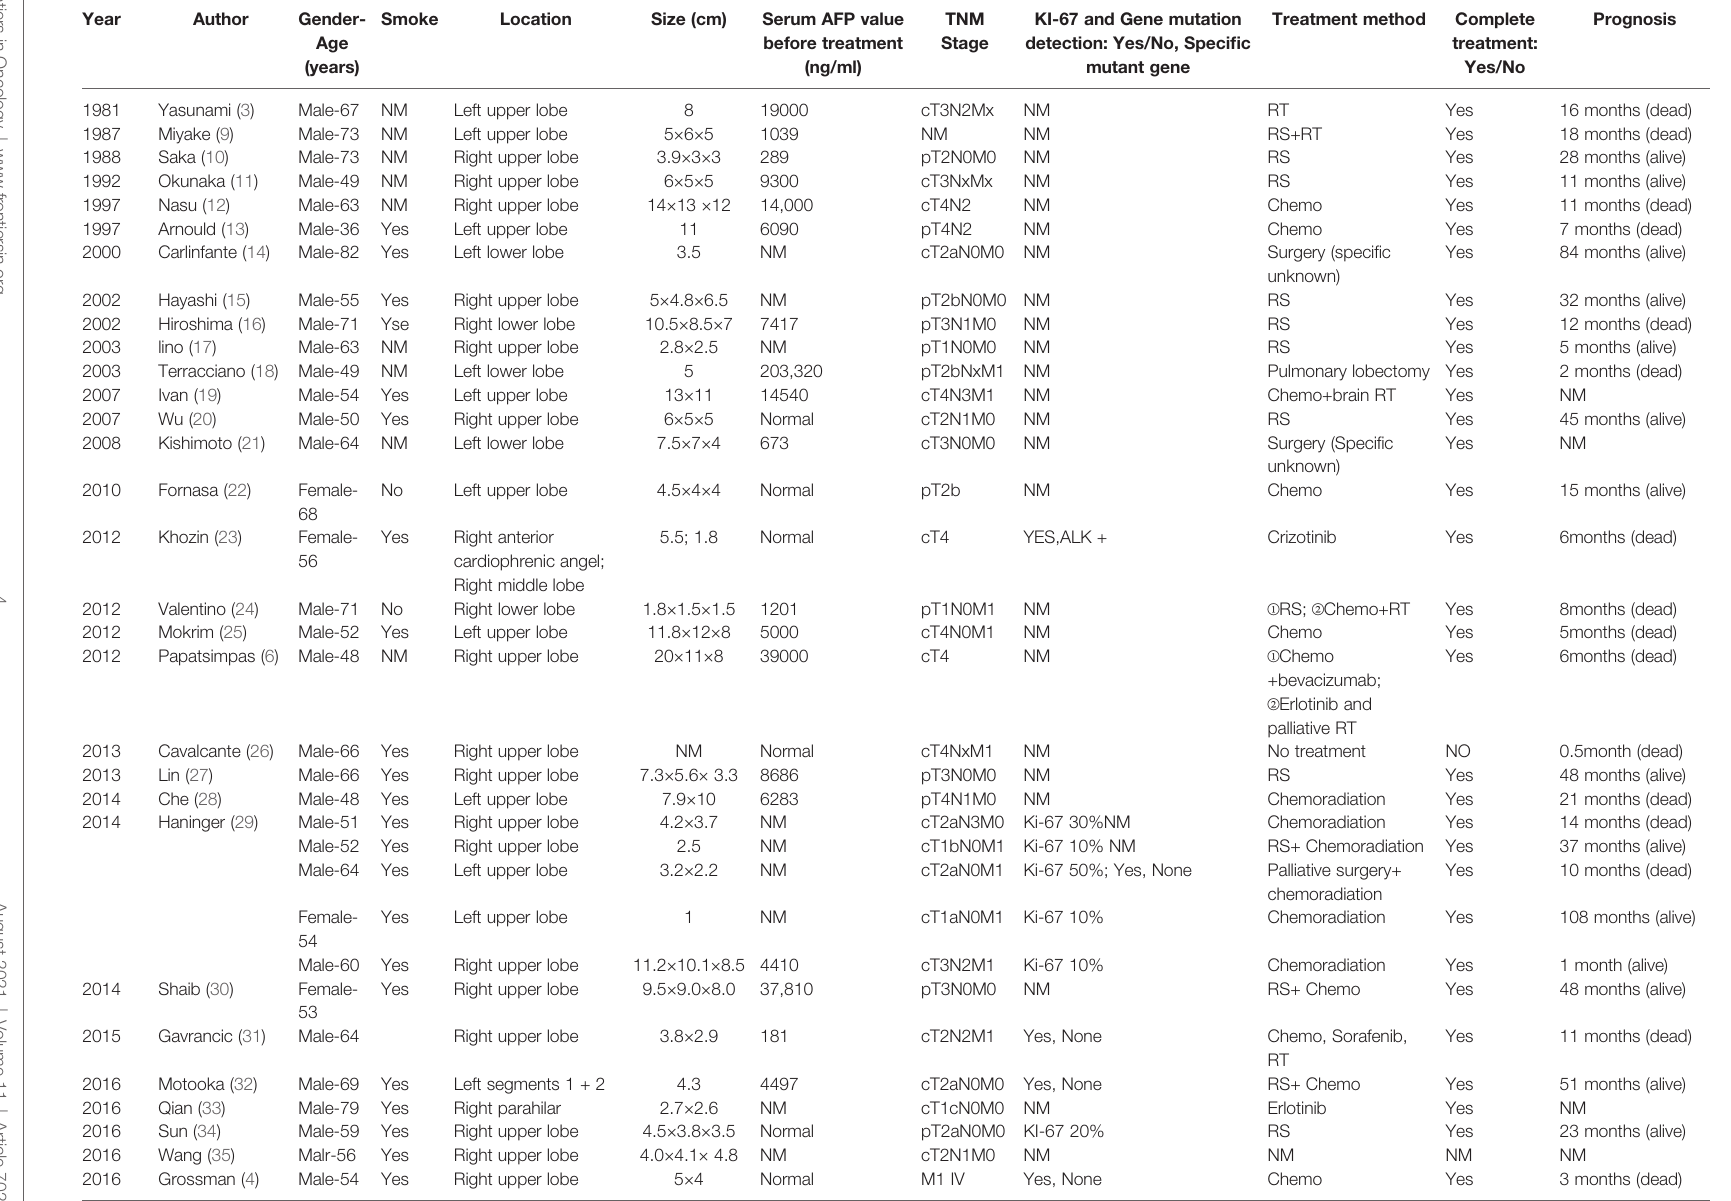
TABLE 1 | The clinical data of 51